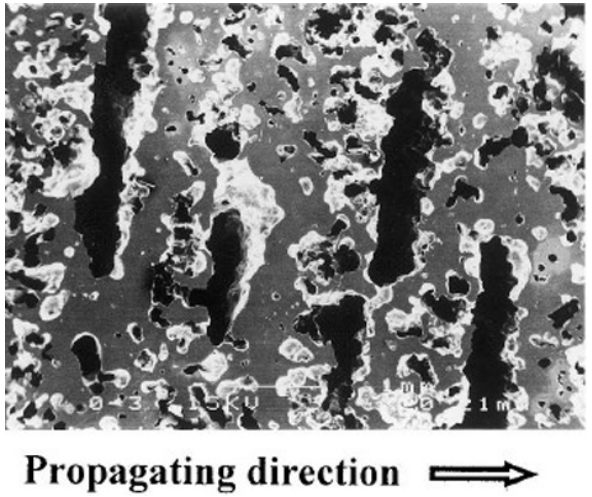
Figure 24. SEM micrographs of the longitudinal section of the porous Ni-Ti SMA with a banded structure showing channels along the propagating direction of combustion wave [282]. Reprinted with permission from [282]. Copyright 2000